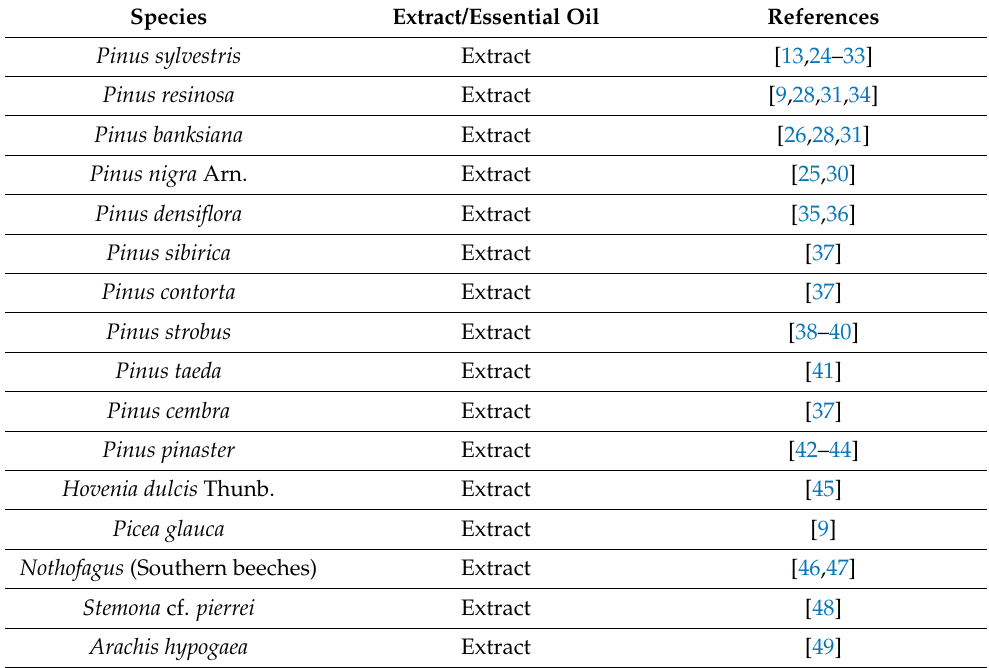
Table 1. Sources of